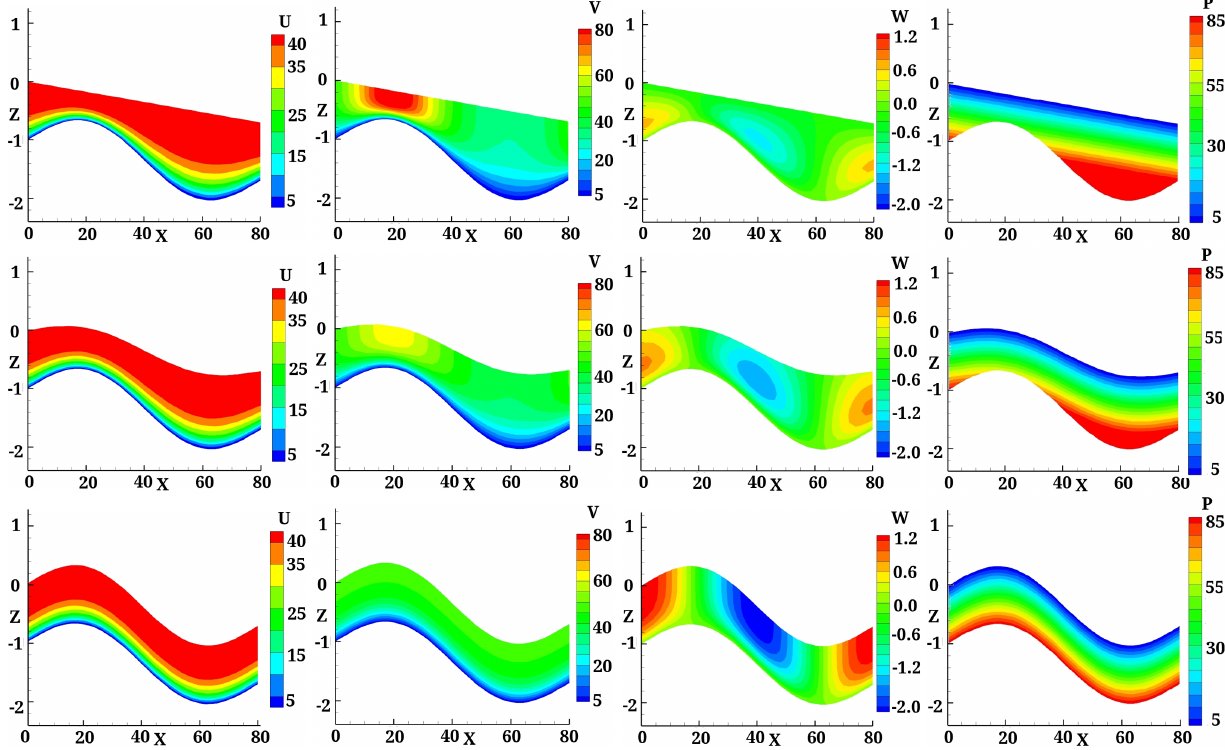
Fig. 3. Analytical solution along the cross section y = L/ 4 of the ice sheet. From left to right: the velocity components u , v , and w (ma − 1 ) and the pressure p (10 5 Pa). From top to bottom: t = 0, 100, and